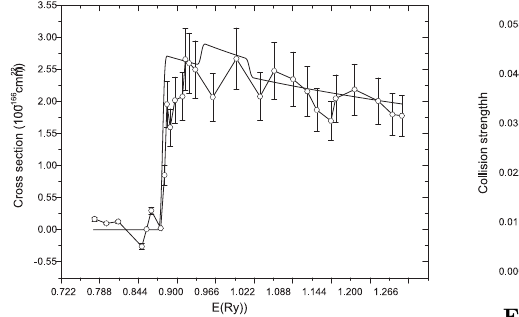
Fig. 1. Present cross sections (solid line) of the 2 s 2 S (cid:0) 2 p 2 P o transition as a function of electron energy near the exci- tation threshold. Experimental results of Lozano et al. (2001) are also plotted (the solid line + circles)